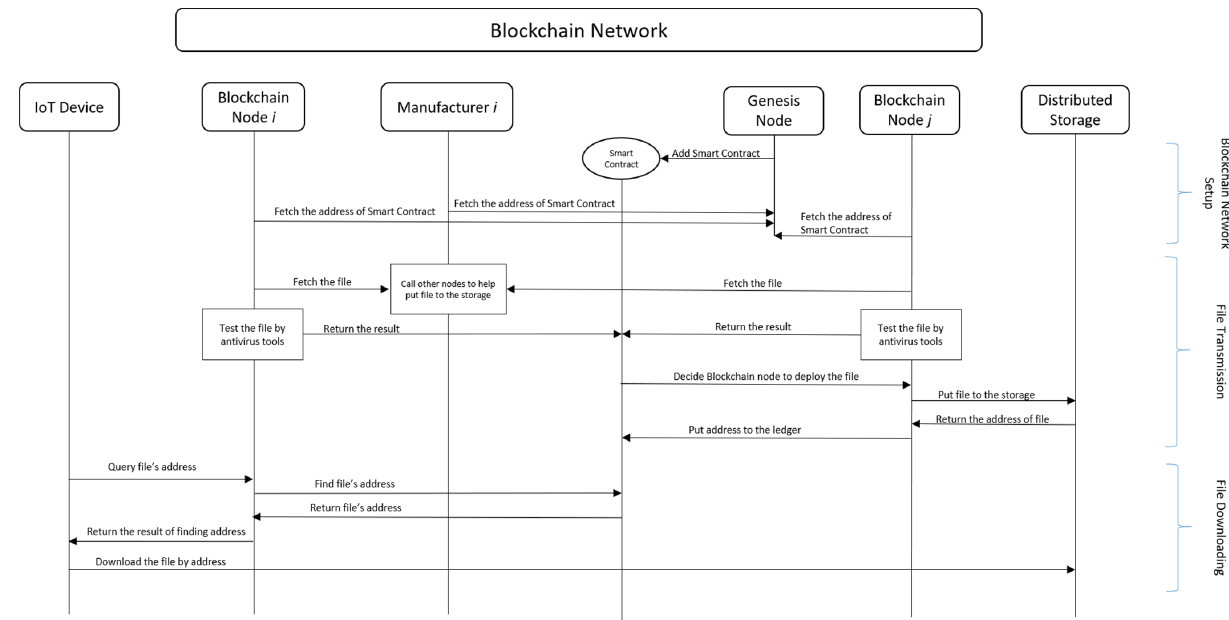
Figure 2. Process flow of the proposed firmware update mechanism.